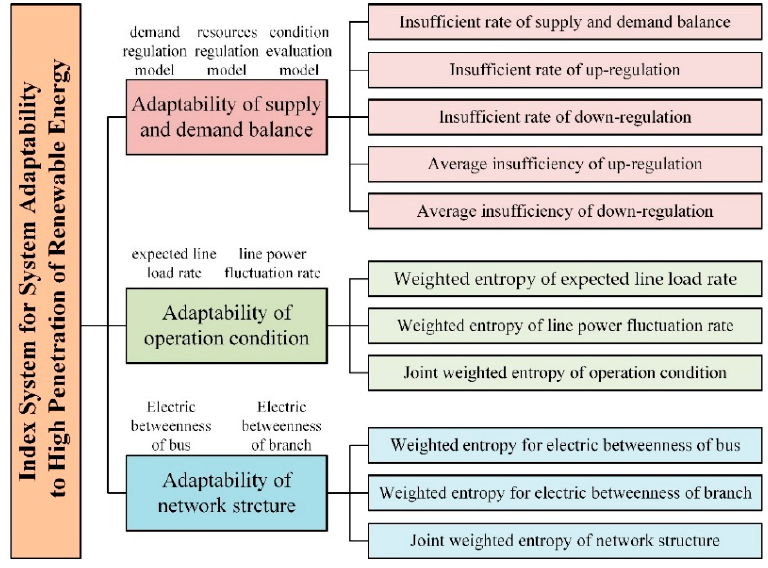
Figure 2. Evaluation index system for system adaptability to high penetration of renewable energy.